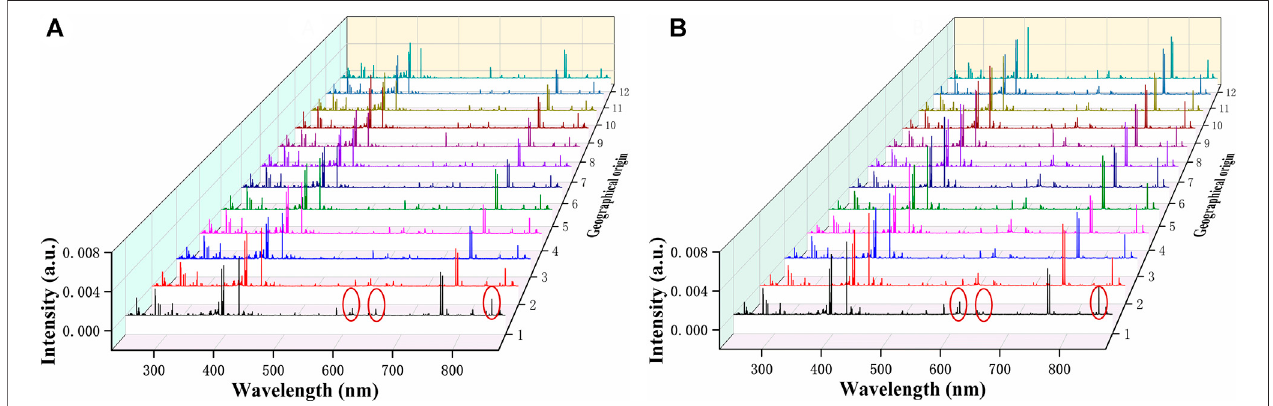
FIGURE 4 | The average LIBS spectra of G. rigescens Franch from 12 geographical origins: (A) underground parts and (B) aerial